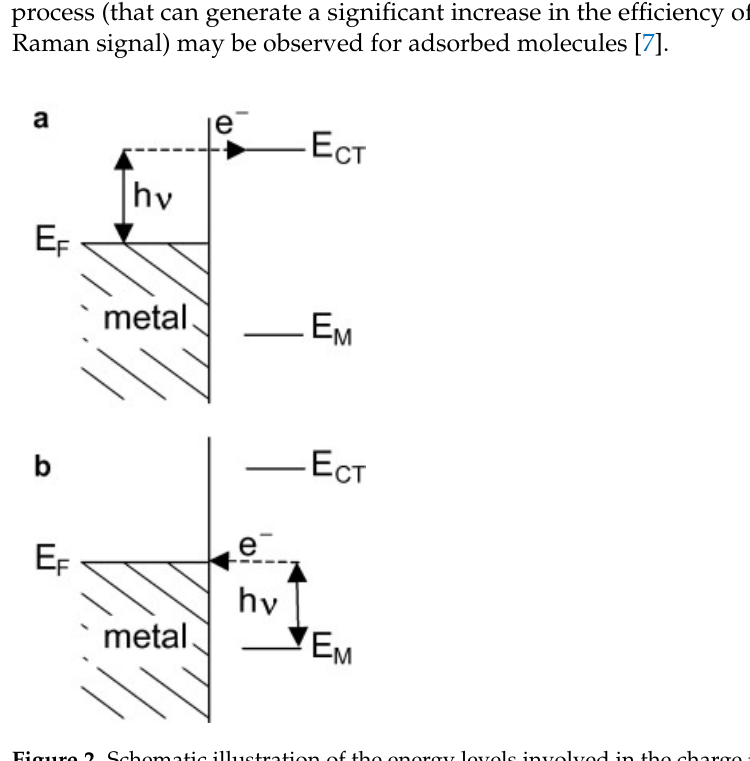
Figure 2. Schematic illustration of the energy levels involved in the charge transfer (CT) mecha- nism of the surface-enhanced Raman scattering (SERS) enhancement; h ν —photon energy, E F — Fermi level energy, E CT —energies of occupied and unoccupied levels of the adsorbed molecules. ( a ) The electrons at the Fermi level of the metal are virtually excited into unoccupied molecular orbitals of the adsorbed molecule and back to the metal, ( b ) the electrons at the highest occupied molecular orbital can be virtually excited into the Fermi level of the metal and back to the adsorbed molecule. Reproduced with permission [7]. Copyright, 2009,